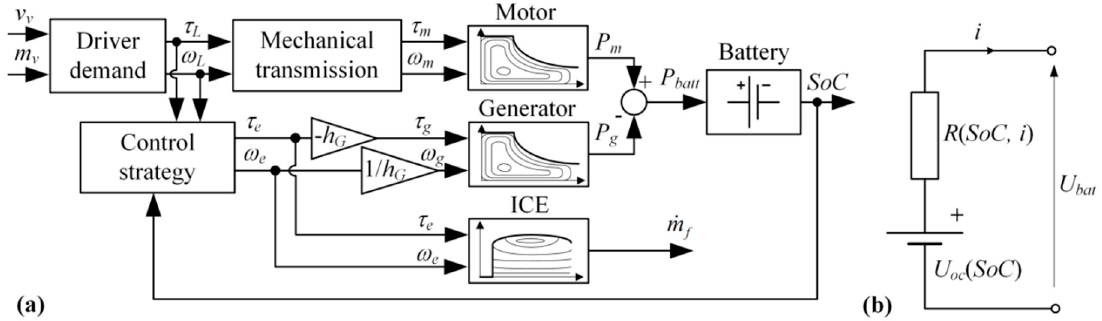
Figure 5. Block diagram of the backward-looking model of EREV truck powertrain ( a ), and equivalent battery circuit ( b ) [4].